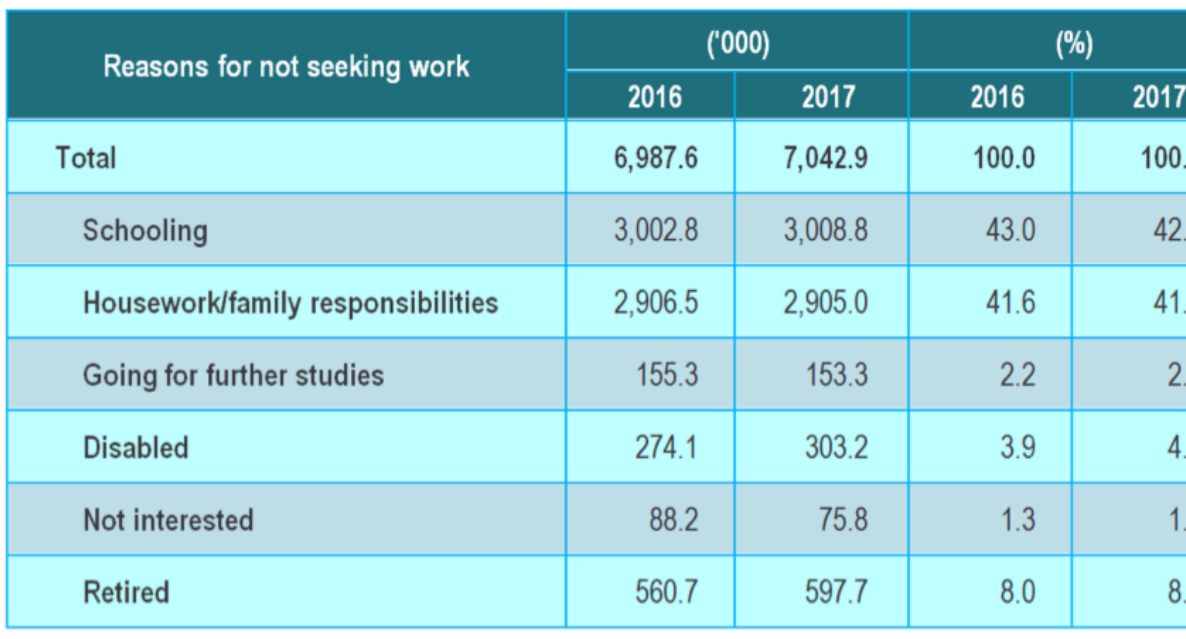
Figure 1. Population Outside Labour Force by Reasons for not Seeking Work, Malaysia, 2016 and 2017 (Source from: Statistic Department of